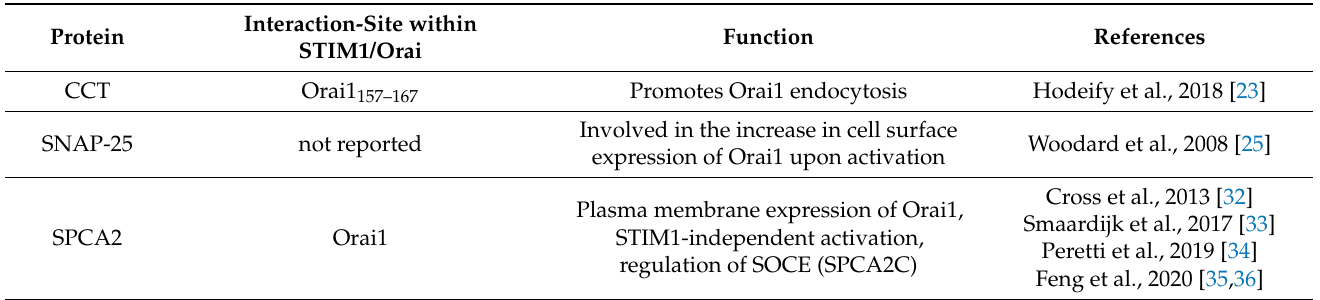
Table 1. Regulatory proteins within the calcium-release-activated calcium (CRAC) signalling cascade.